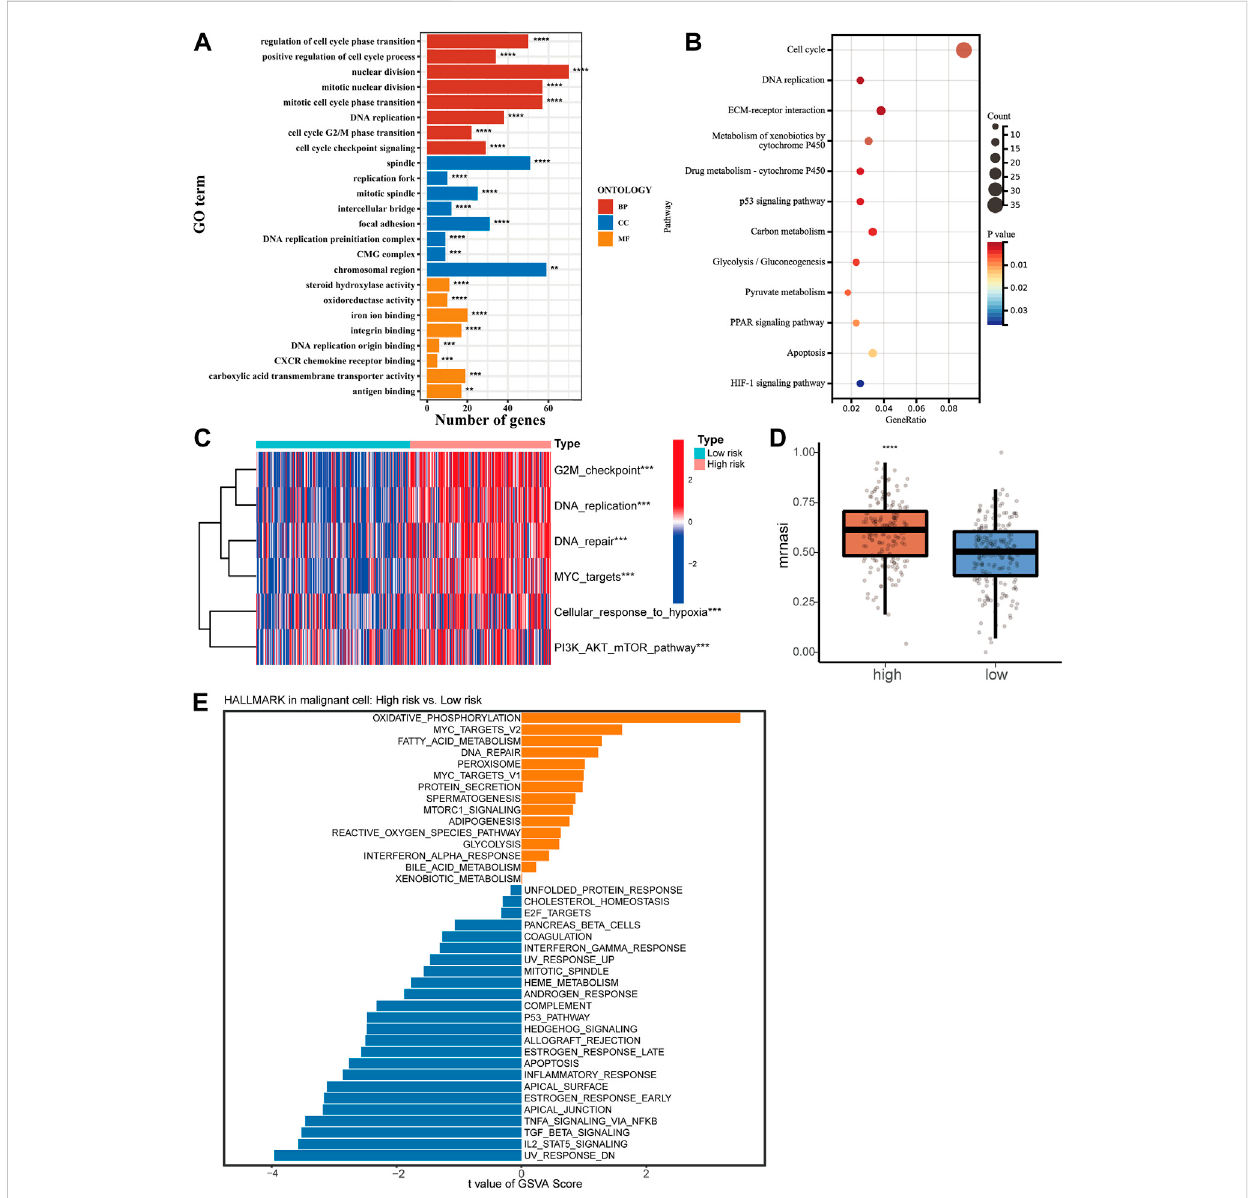
FIGURE 4 Functional enrichment analysis of high- and low-risk groups. GO analysis (A) and KEGG analysis (B) of DEGs between the high-risk and low-risk groups. (C) Heatmap of ssGSEA scores in proliferation-related pathways. (D) Correlation between mRNAsi score and risk score of thesignature. (E) GSVA for malignant cells from single-cell